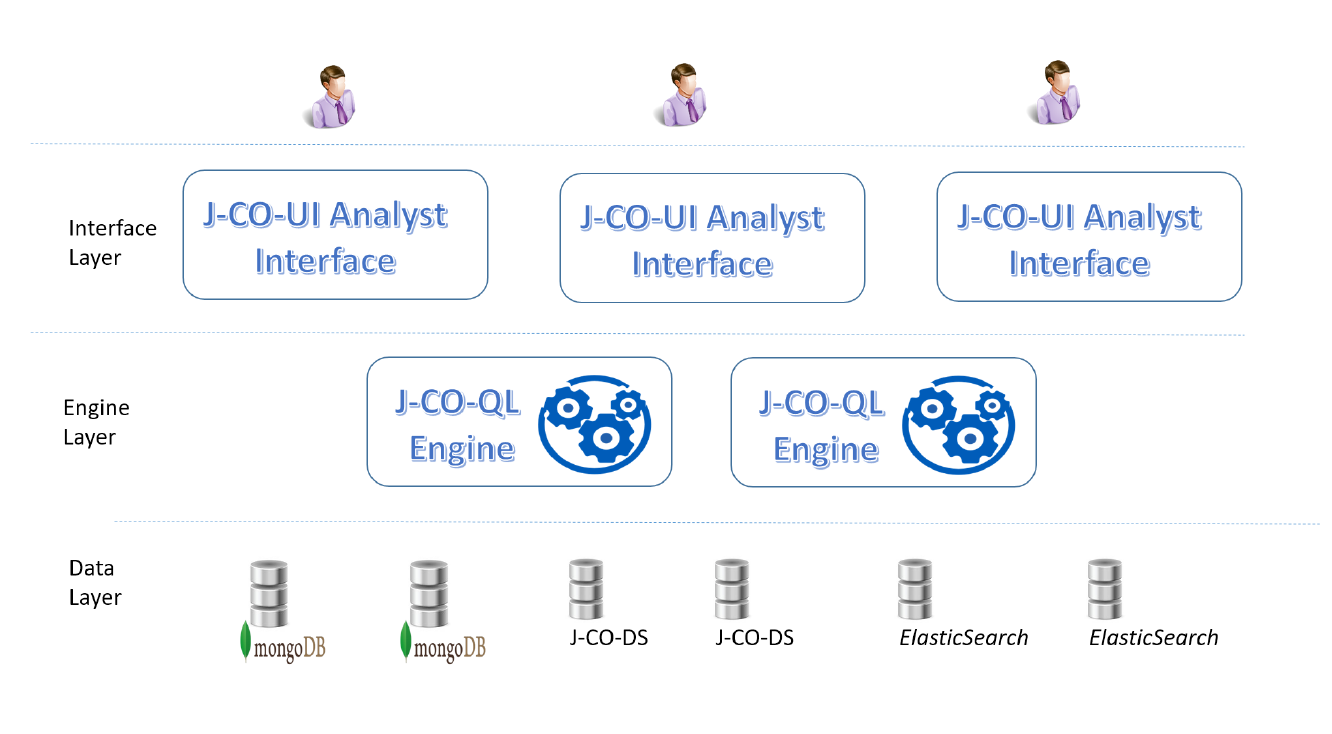
Figure 1. Application Layers for the J-CO